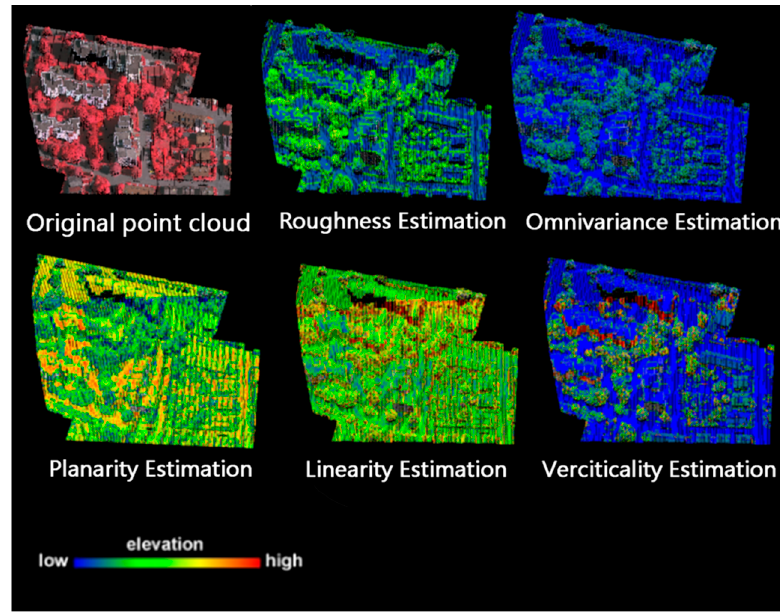
Figure 1. Estimated values of each